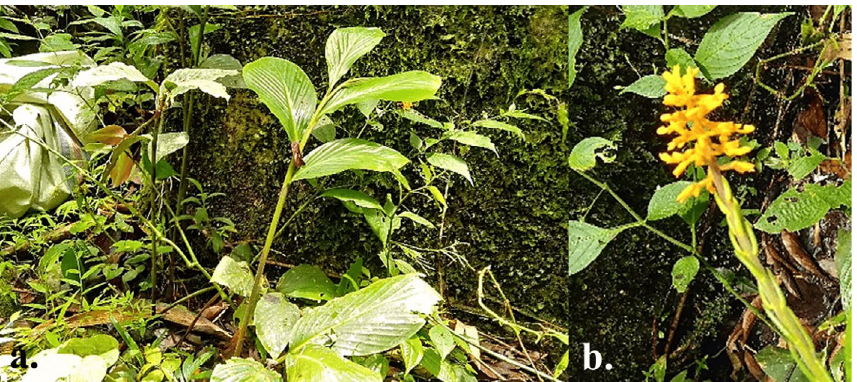
Fig. 1. (a) Leaf and (b) inflorescence part of Globba patens Miq. collected from Sibolangit forest, North